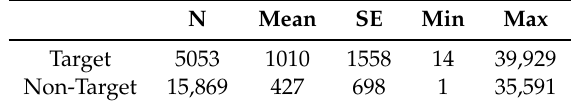
Table 5. CNN statistics on the cascade size. KS-test for target and non-targets: D = 0.068, p ≈ 0.0. N